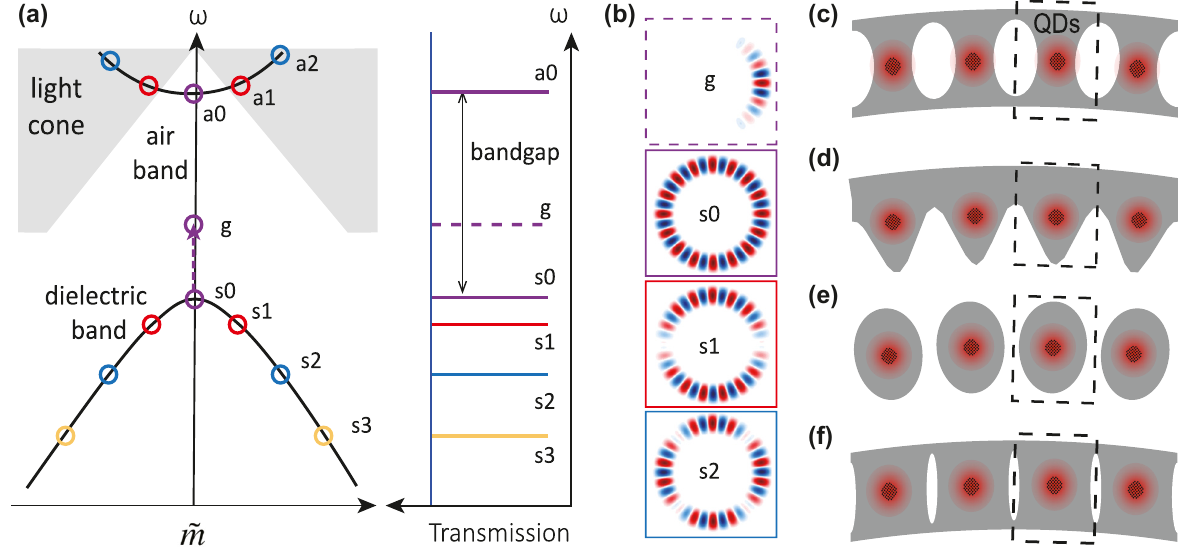
Figure 1: Photonic crystal ring (PhCR) for cavity quantum electrodynamics (cQED). (a) Band diagram for a PhCR. Air band modes are pushed up in frequency towards the light cone, and only those below the light cone are observed in waveguide-coupled transmission measurements. Dielectric band modes are compressed in free spectral range (the frequency separation between adjacent modes) around the band edge. The frequency difference of the air and dielectric band-edge modes a 0 and s 0 is the bandgap. Through defect localization, a defect mode g can be created from s 0, with its frequency pushed into the bandgap. These mode characteristics can be observed in cavity transmission spectroscopy if the modes are properly waveguide-coupled. (b) Illustration of the spatial electric field profiles of the defect and dielectric band-edge modes. All these modes are redistributions in azimuthal angle, with similar mode profiles in a unit cell. (c)–(f) Illustration of four types of unit cells in PhCRs, whose characteristic shapes are referred to hereafter as “holes”, “microgear”, “rods”, and “slits”, respectively. Quantum dots (QDs), as a representative quantum emitter for future cQED experiments, are illustrated at the center positions of each